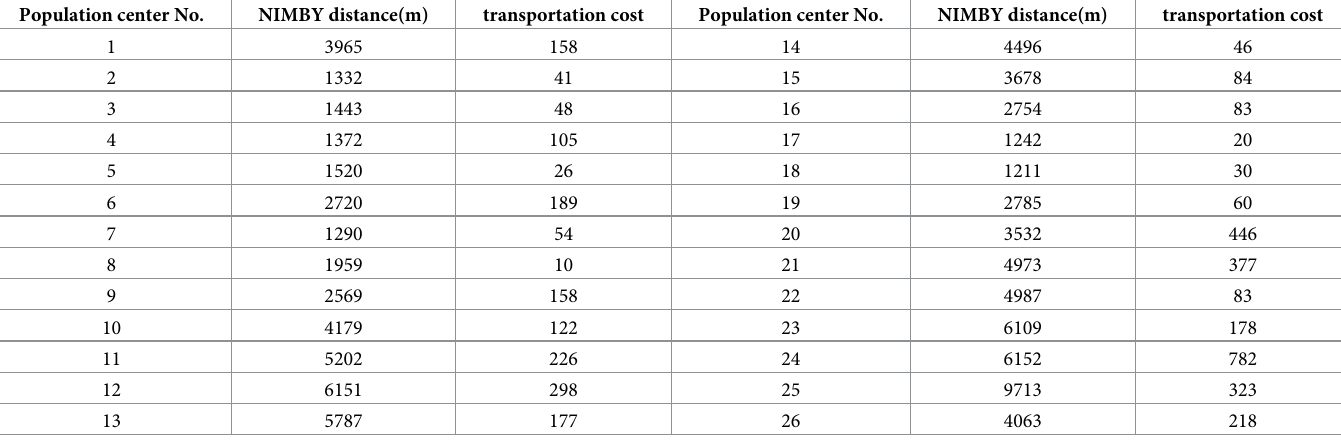
Table 4. NIMBY distance and waste transportation cost of population centers in scheme #5 under Model 1. Population center